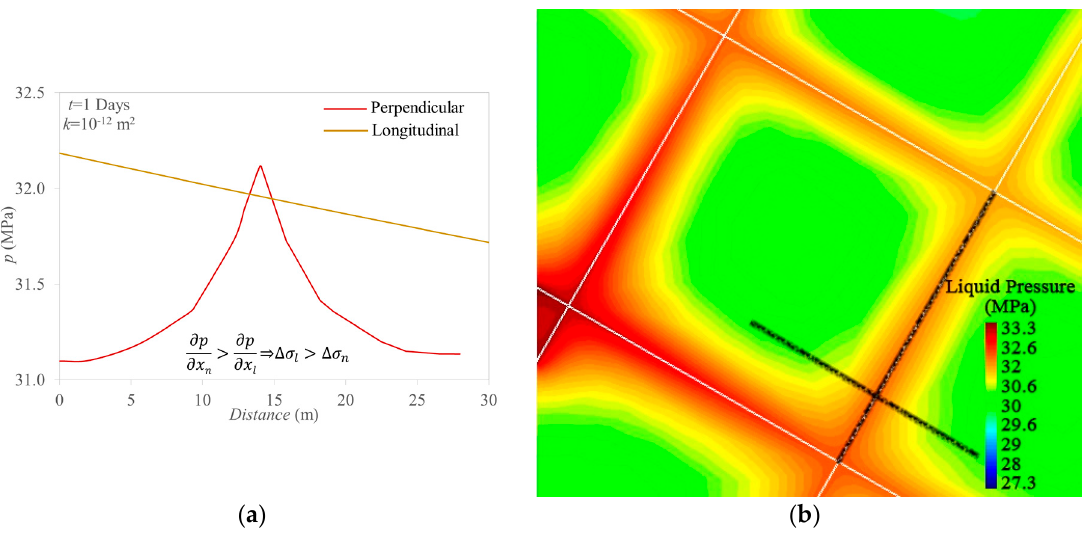
Figure 8. ( a ) Pressure gradient in the longitudinal ( x l ) and normal ( x n ) directions of a fracture after 1 day of injection and ( b ) fluid pressure distribution due to injection into a fractured medium and sections depicted in the profiles shown in ( a ). Note that pressure buildup mostly propagates into the longitudinal direction of a fracture. Consequently, the pressure gradient in the normal direction is greater than in the longitudinal direction.